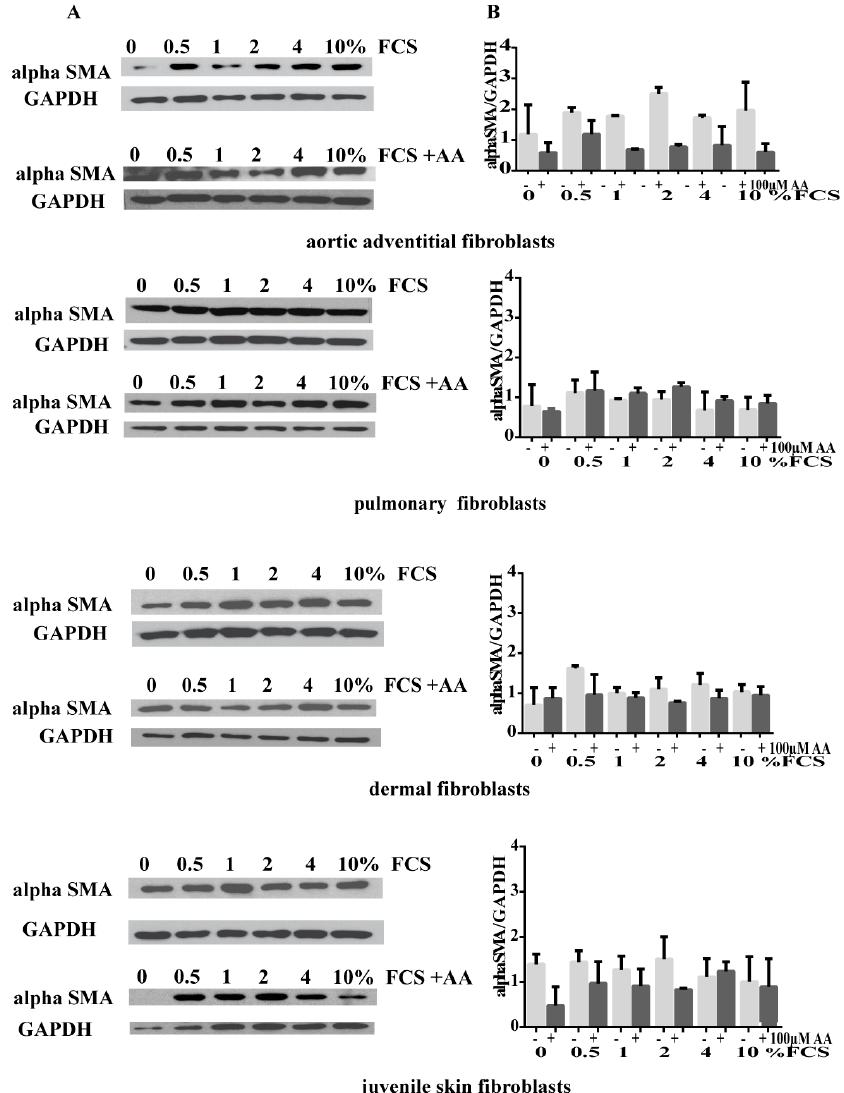
Figure 2. Expression levels of alpha SMA with different concentrations of FCS and FCS plus 100 µM Ascorbic acid in culture medium in fibroblasts. ( A ) Expression levels of α SMA are illustrated by immunoblots as indicated. For normalization, protein levels of GAPDH are demonstrated. ( B ) Quantification of α SMA is present as ratio of α SMA/GAPDH signal. Data are the mean of at least 2– 4 experiments with polyclonal and monoclonal Abs for α SMA.